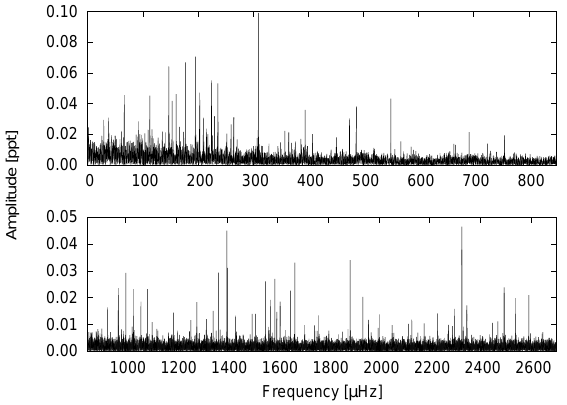
Figure 2. Close-ups of the g-mode (top panel) and p-mode (bottom panel) regions. Note different scales of the vertical axes in two pan-